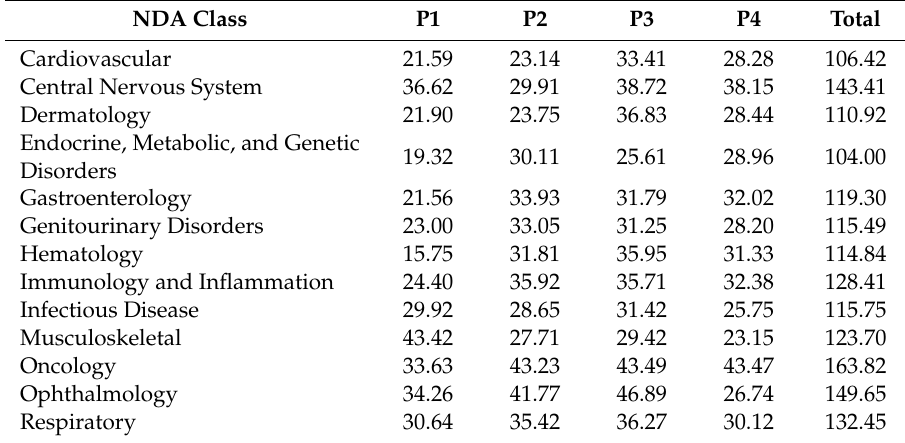
Table 11. Development period (month) in each NDA drug class/phase for the whole period (1970–2017).